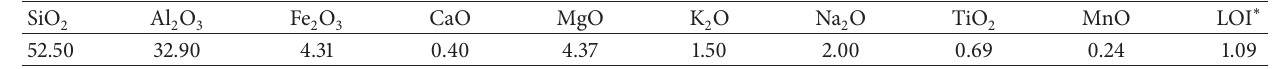
Table 1: Chemical composition of Hwangtoh (% by mass).